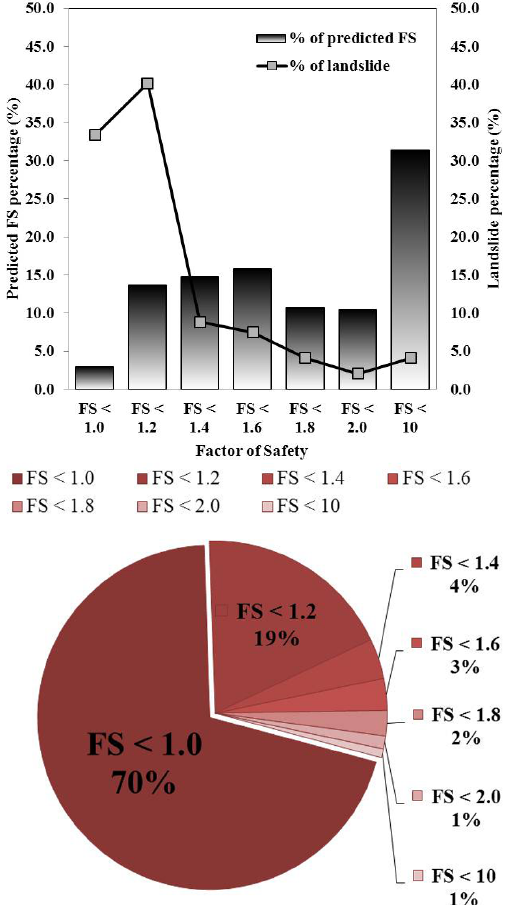
Fig. 14. Results obtained by TRIGRS in each